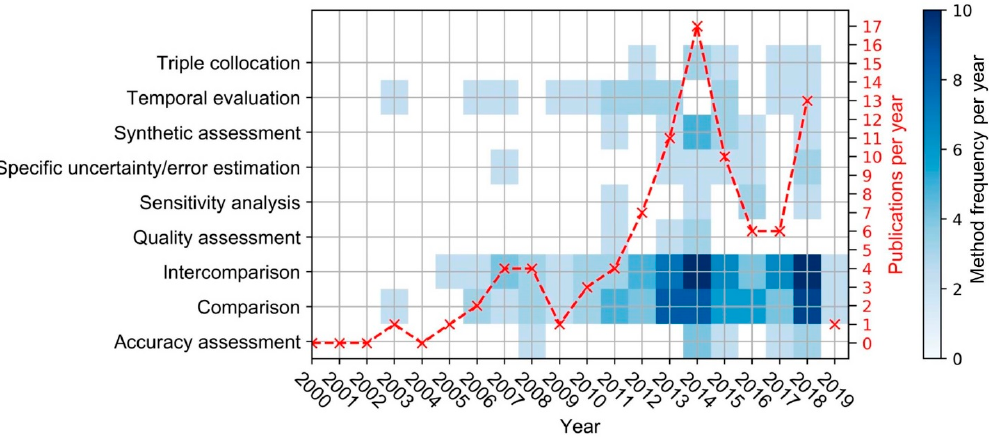
Figure 15. Temporal development of the number of relevant publications and application frequency of validation methods (trend to 2019 is not indicated).